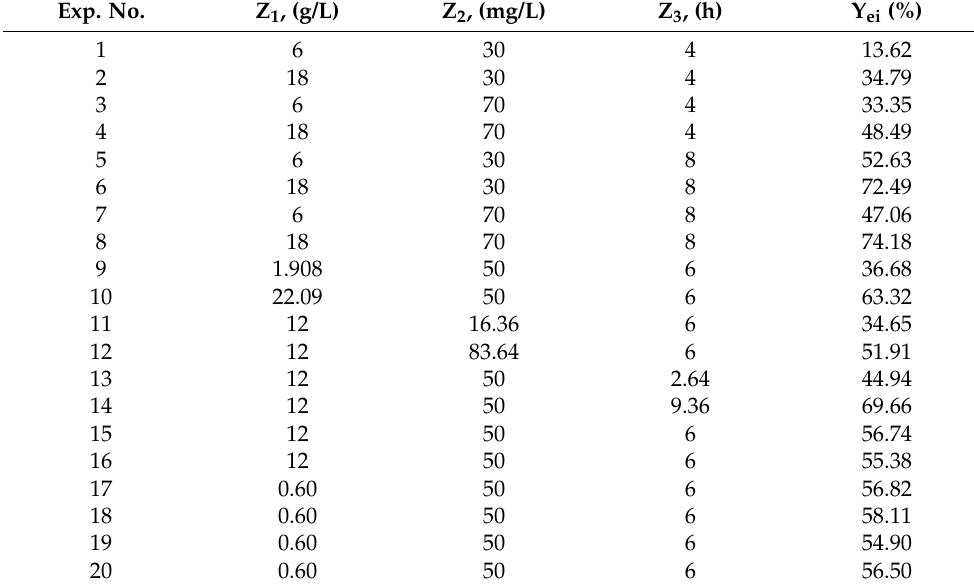
Table 1. Example of the experimental planning matrix used in the statistical analysis.